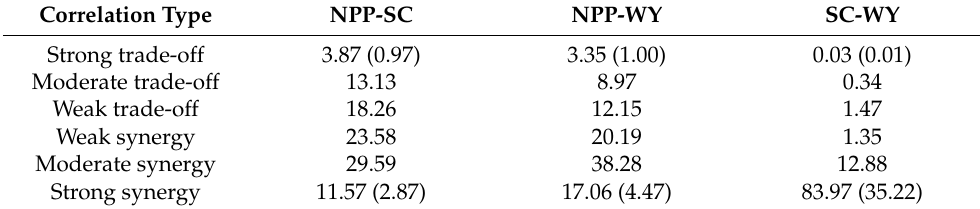
Figure 5. Significance of trade-offs and synergies between ecosystem services on multi-scale: Figure 5. Signi fi cance of trade-o ff s and synergies between ecosystem services on multi-scale: ( a , d , g ) ( a , d , g ) watershed scale; ( b , e , h ) county scale; ( c , f , i ) grid scale. watershed scale; ( b , e , h ) county scale; ( c , f , i ) grid scale. Table 4. Proportion of Area of Trade-off and Synergy between Ecosystem Services